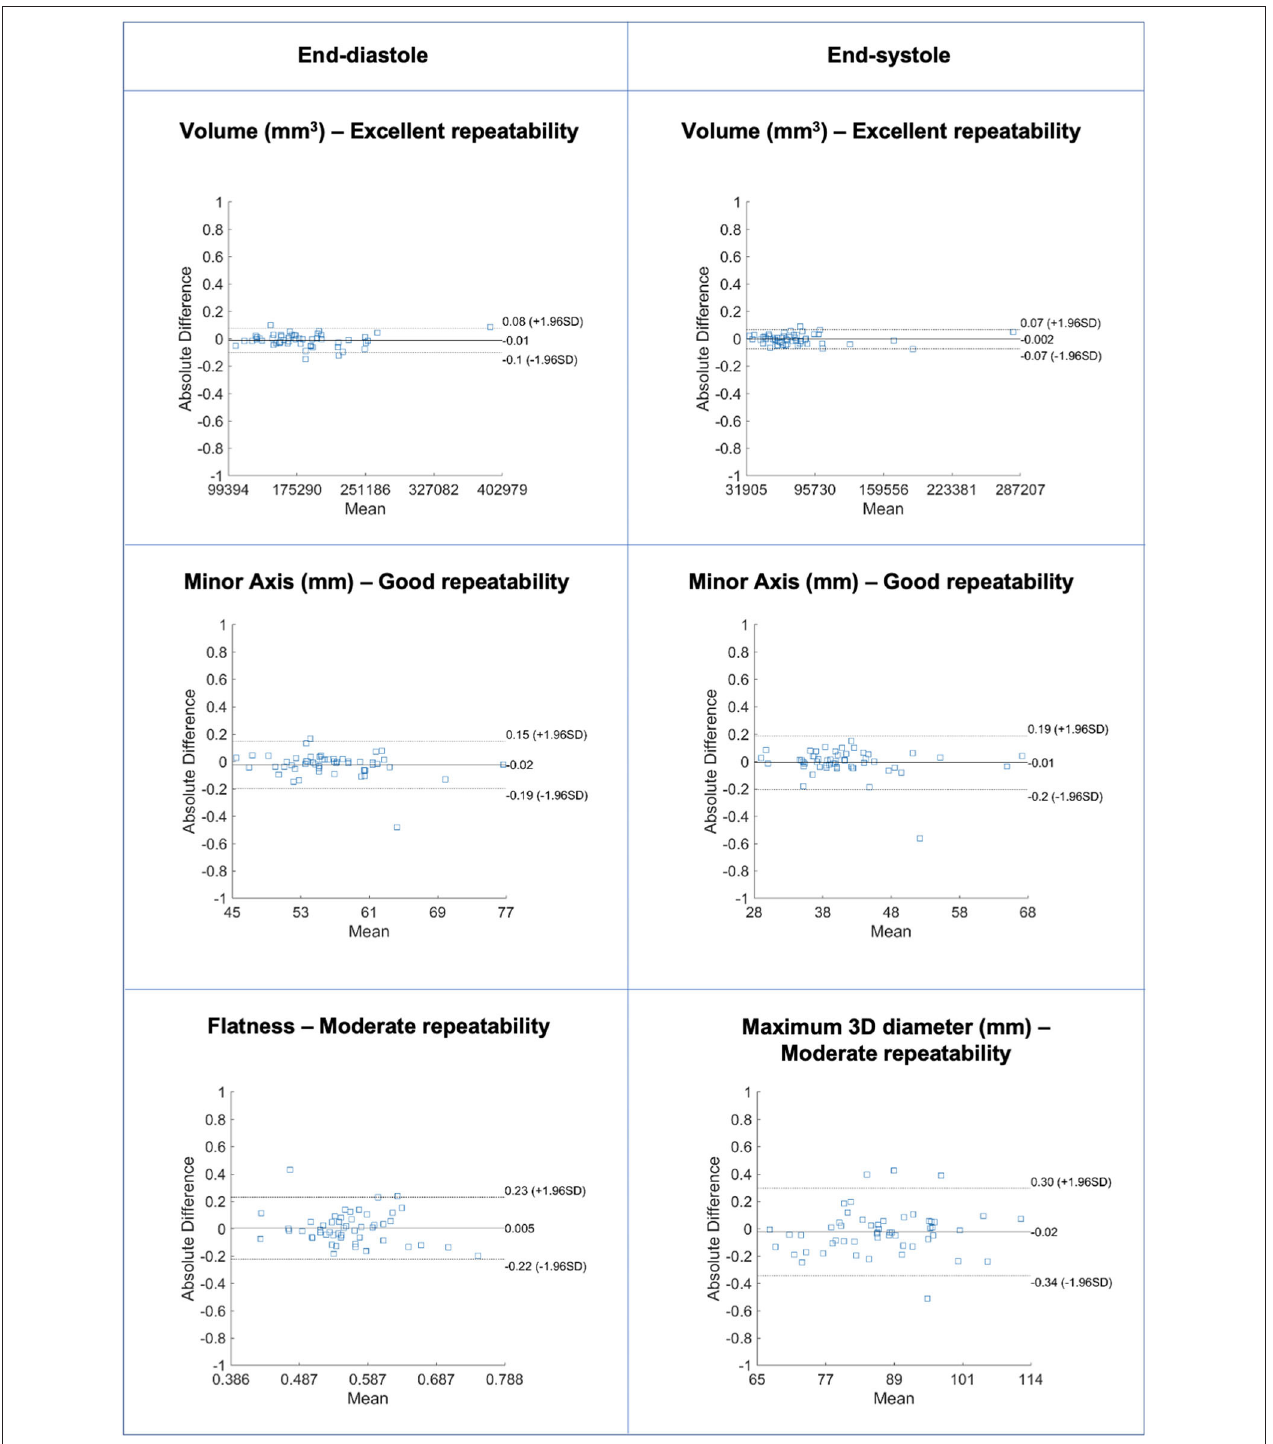
FIGURE 2 | Bland-Altman plots for selected LV blood pool shape features in end-diastole (left) and end-systole (right) with different levels of repeatability. Differences in Bland-Altman are calculated after normalizing radiomics in the range [0–1] to facilitate comparison among different features. All features are unitless. LV: left ventricle. was used before computing the features. We considered all CMR and mask volumes) using the open-source python- features available in Pyradiomics including older versions based PyRadiomics platform version 2.2.0 in end-diastole in an effort to provide robustness insights for features, that and end-systole. No pre-processing or re-segmentation